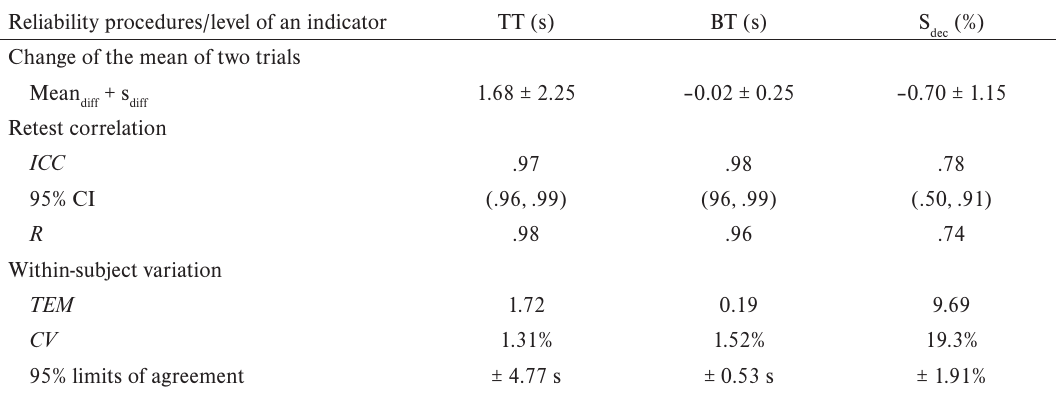
Overview of reliability analysis indicators Reliability procedures/level of an